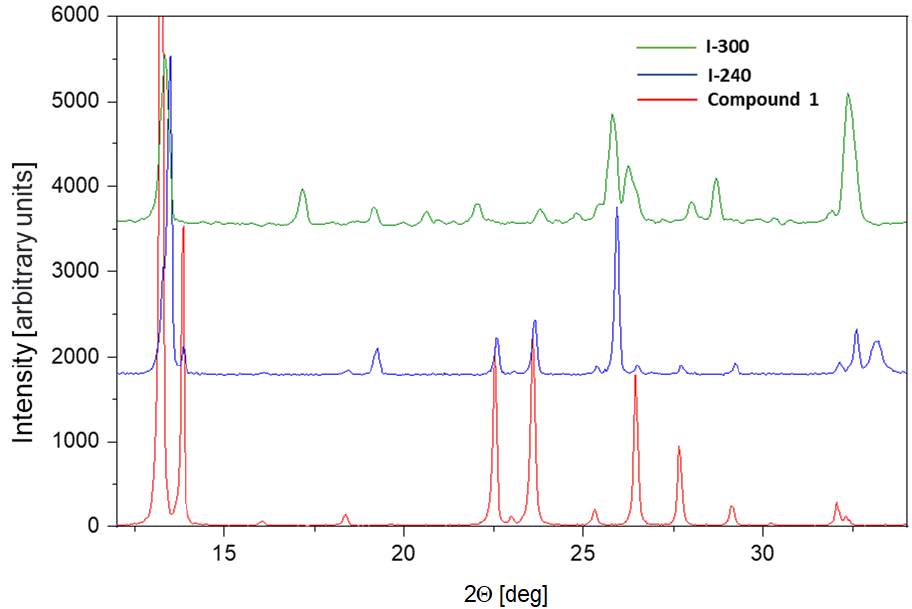
Figure 10. The powder X-ray diffractogram of compound 1 and decomposition intermediate 240 at 300 °C.